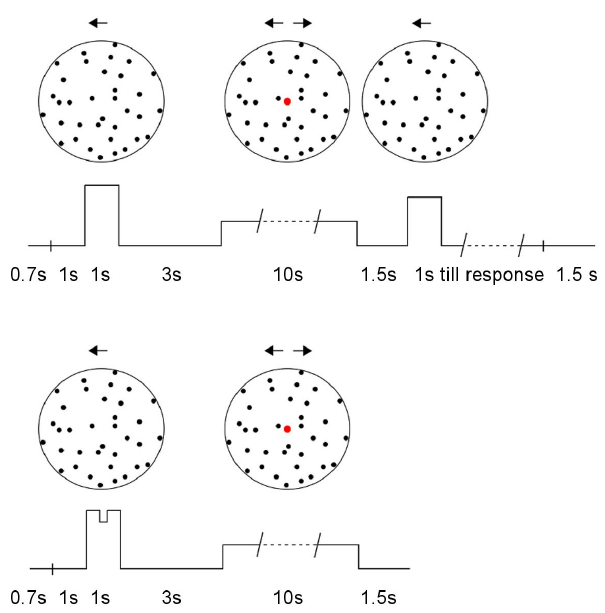
Figure 1. Trial procedure in the WM condition ( upperpanel ) and in the attention condition ( lowerpanel ). The direction of motion of the stimuli is represented by solid arrows above them, their duration and speed is depicted as a line below them. Observers memorized the speed of motion of the initial unambiguous sphere in the WM condition and reported the brief change in its speed in the attention condition. Subsequently, observers continuously reported the perceived direction of motion of the ambiguous sphere. Only in the WM condition observers reported whether the speed of the unambiguous sphere presented at the end of the trial was higher than the memorized